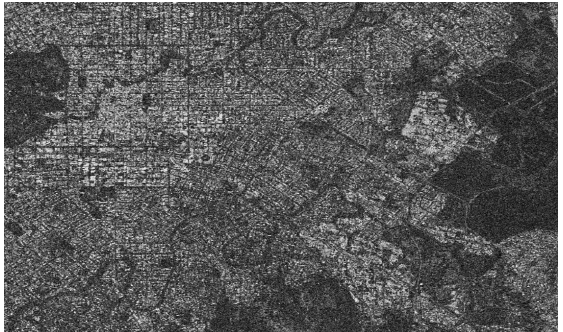
Figure 4. Coherence image of Christchurch after the earthquake of 22 February 2011